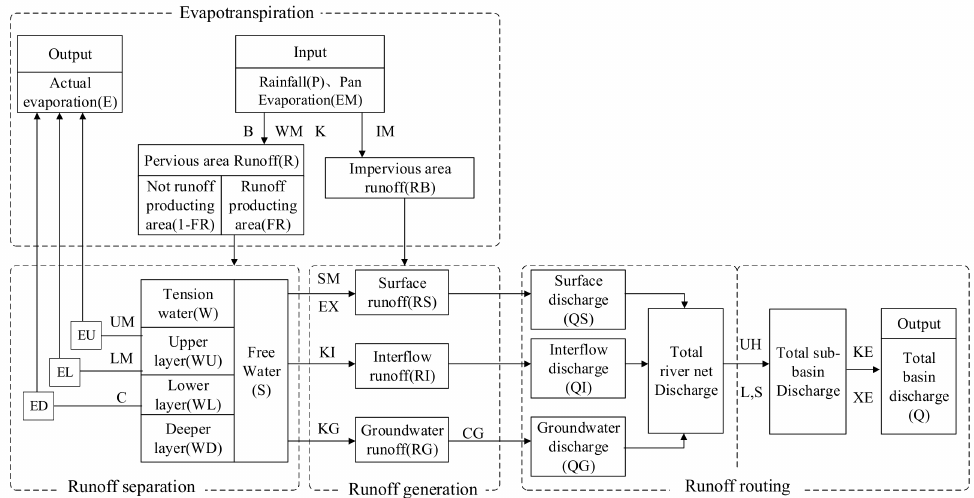
Figure 2. Flow chart of the Xinanjiang